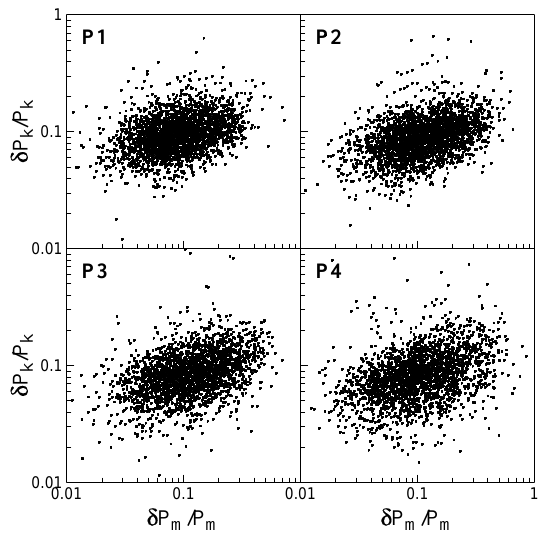
Fig. 12. Scatter plots of the relative amplitudes of total pressure vs. density fluctuations for polar wind samples P1 to P4. Straight lines indicate the Tu and Marsch (1994) model predictions for different values of α , the relative PBS/W contribution to density fluctuations.